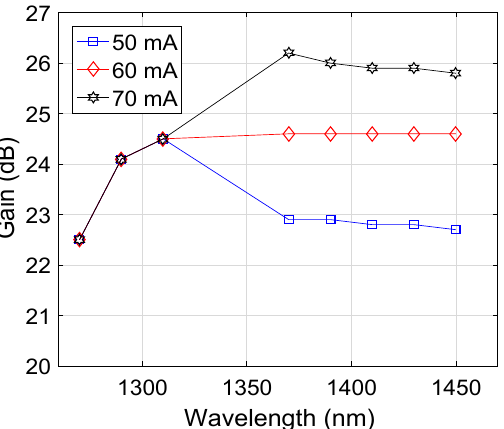
Figure 4. Wavelength versus gain plots as a function of injection